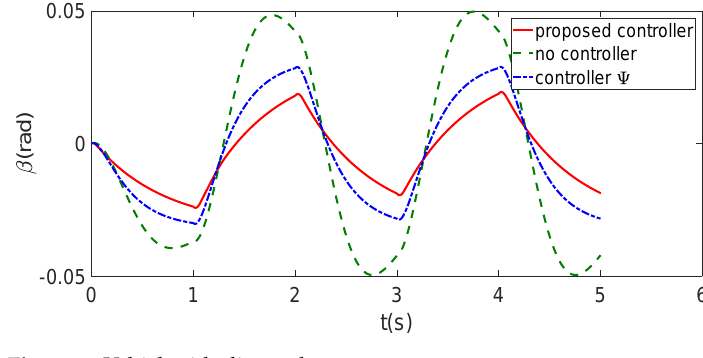
Figure 8. Vehicle sideslip angle.